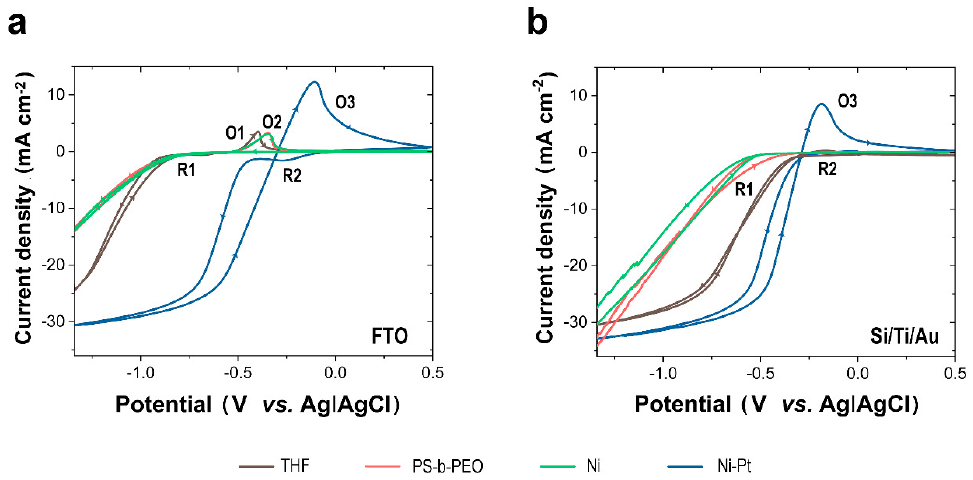
Figure 1. Cyclic voltammograms of the four electrochemical baths (i.e., THF (black), PS- b -PEO (red), Ni (green), and Ni-Pt (blue)) on ( a ) FTO-coated glass and ( b ) Si/Ti/Au at 50 mV s − 1 and 25